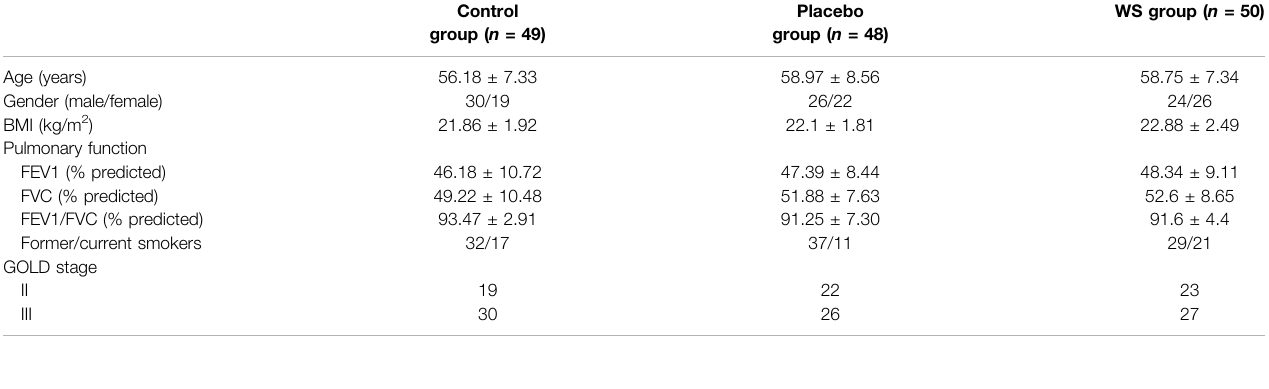
TABLE 2 | Baseline characteristics of the subjects.